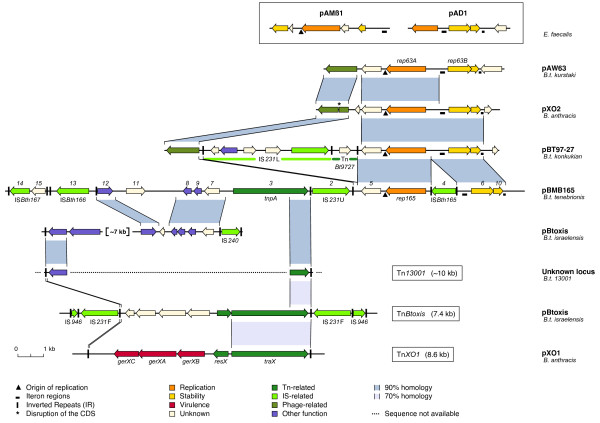
Comparison of the 20 kb fragment carrying the pBMB165 replicon with relational fragments of other plasmids. Predicted functions/homologies are shown by the color key featured below. The origins of replication, iteron regions and IRs are indicated.